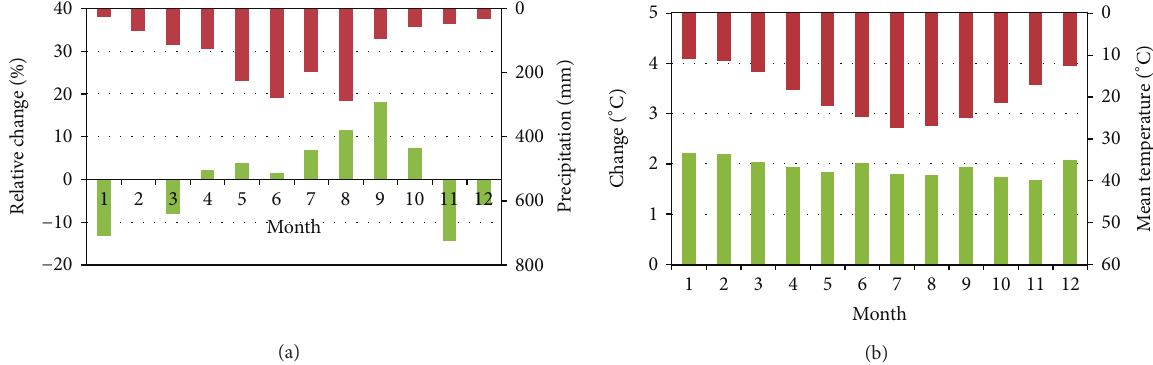
Figure 4: Basin averaged changes (green columns) of monthly mean precipitation and temperature between baseline (red columns) and future climate scenario in the 2050s.